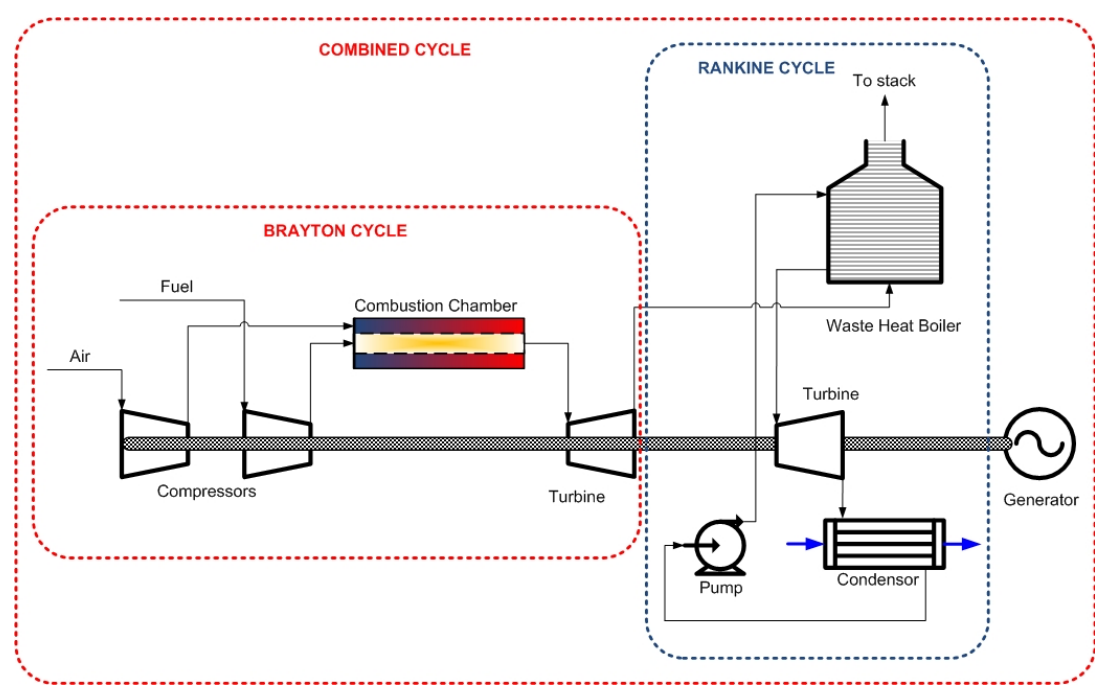
Figure 1. Pictorial representation of a simple combined cycle, including an open Brayton cycle and a bottoming closed Rankine cycle.